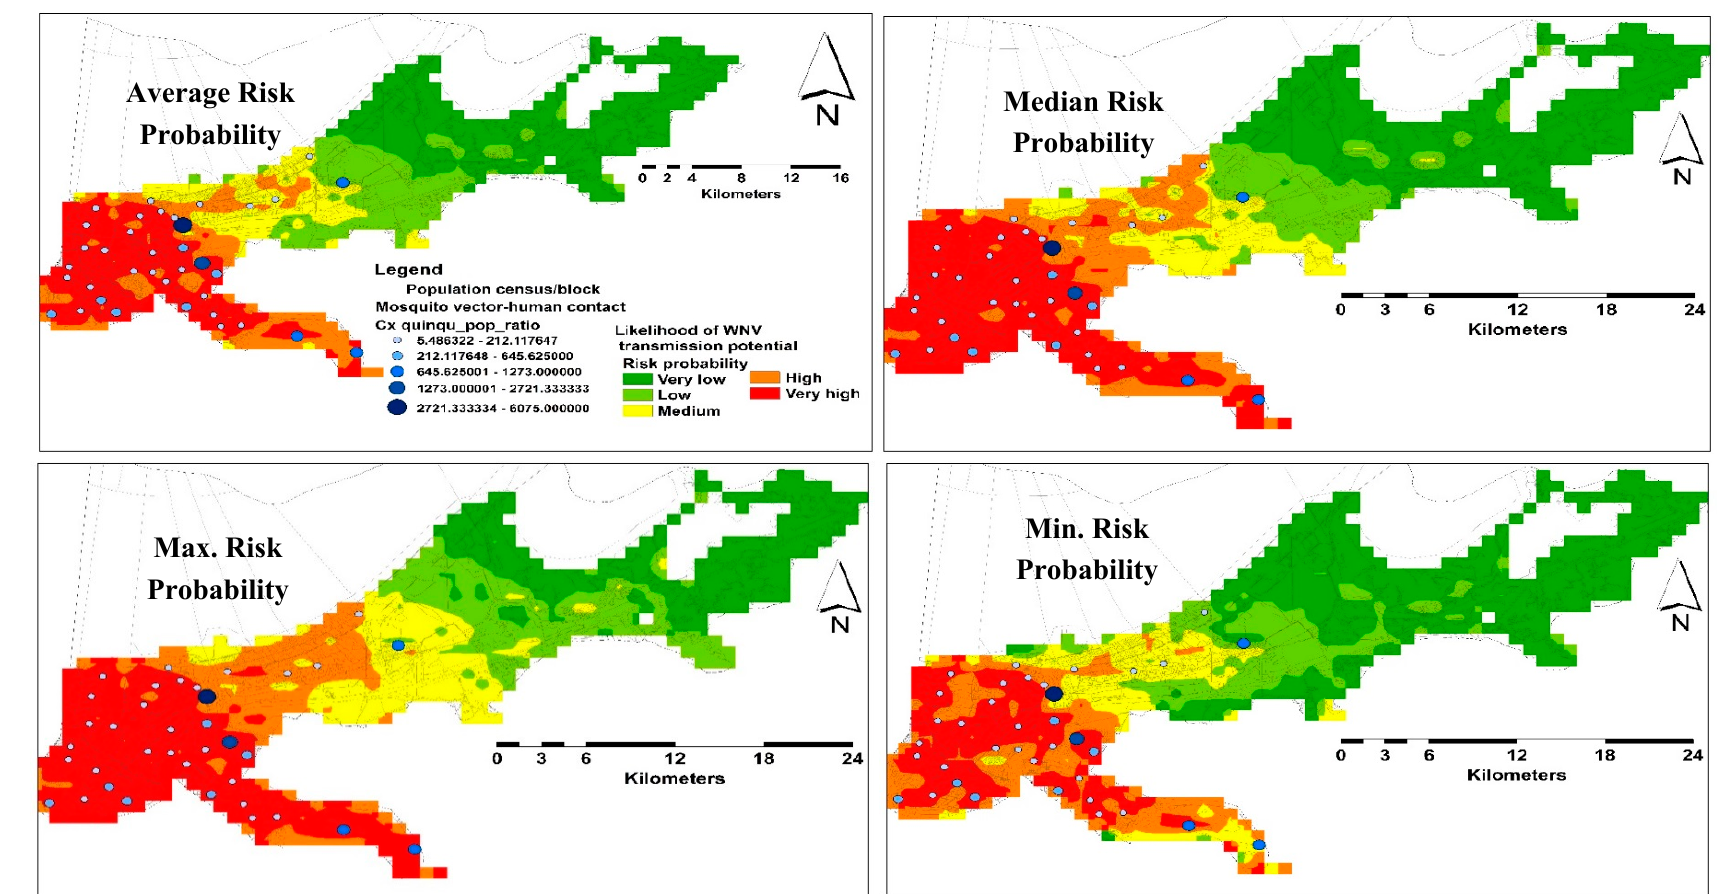
Figure 4. Distribution risk maps for WNV in NOLA representing average, median, maximum, and minimum habitat suitability and sampling localities.